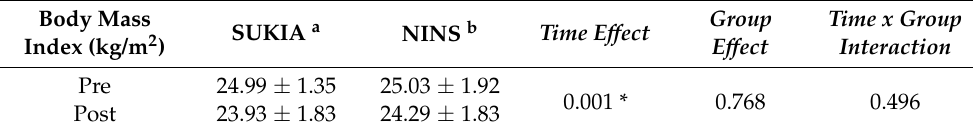
Table 4. Body mass index between SUKIA and